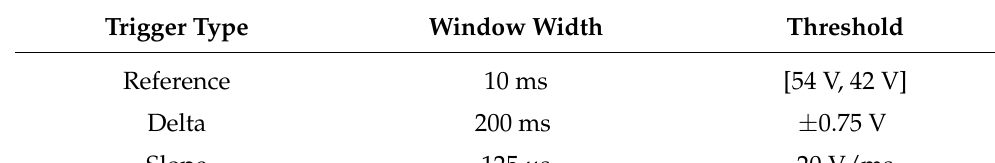
Table 4. Time windows width and thresholds for different DC triggers.